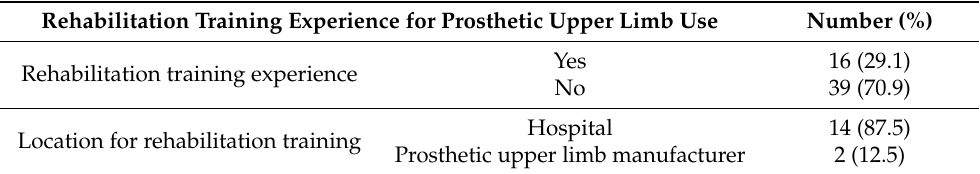
Table 4. Rehabilitation training experience for prosthetic upper limb